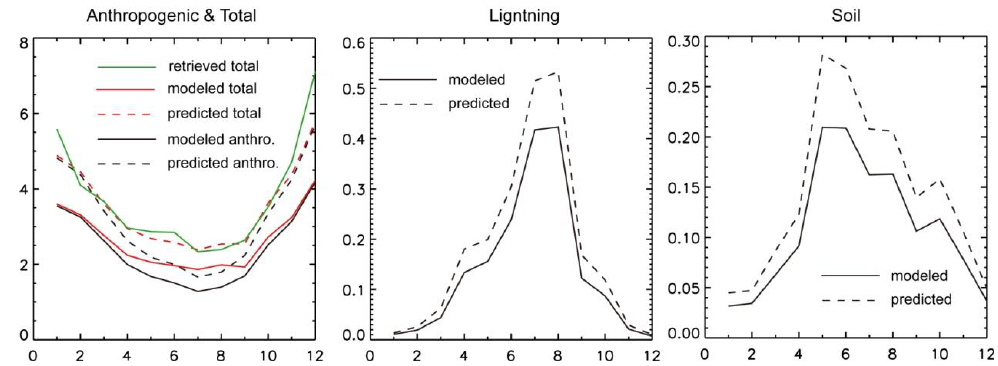
Fig. 5. Seasonal variations of VCDs of NO 2 (10 15 molec.cm − 2 ) over East China for 2006 resulting from anthropogenic, lightning, soil and total emissions of NO x modeled by GEOS-Chem and predicted by the inversion. Also included is the seasonality of VCDs retrieved from OMI.